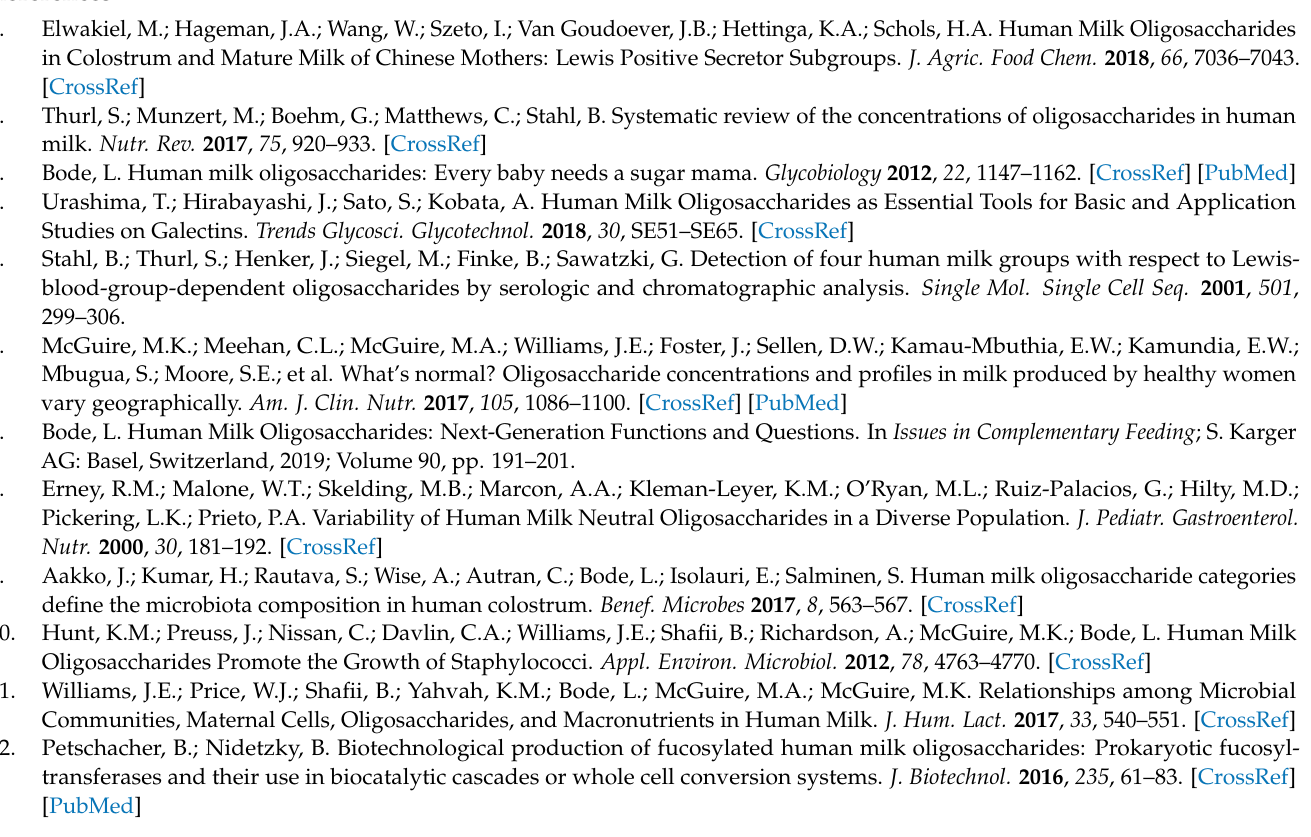
Table S2: Concen-trations of individual HMOs in human colostrum, transitional, and mature milks from mothers with either secretor positive, or unknown secretory status. The concentration (mg/L) of the HMOs was shown as mean ± standard deviation or mean